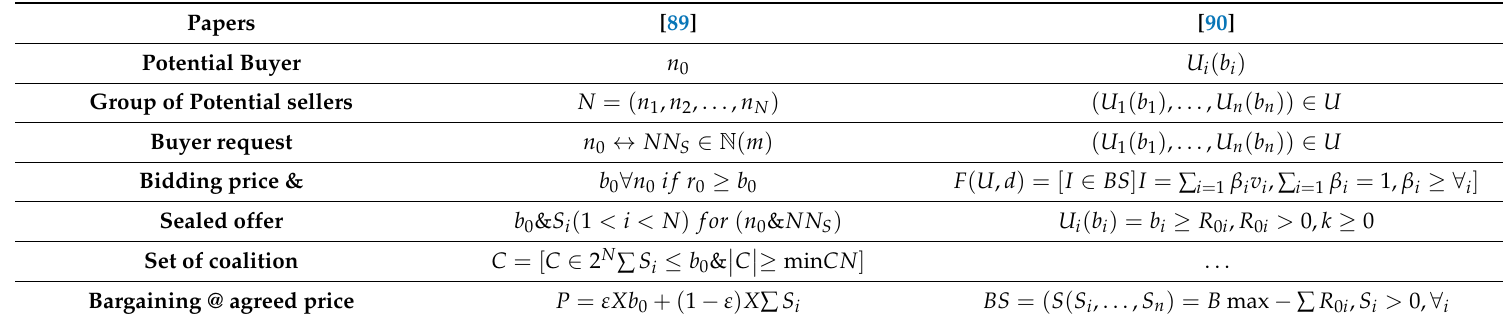
Table A5. Mathematical Comparison of Bargaining Games.